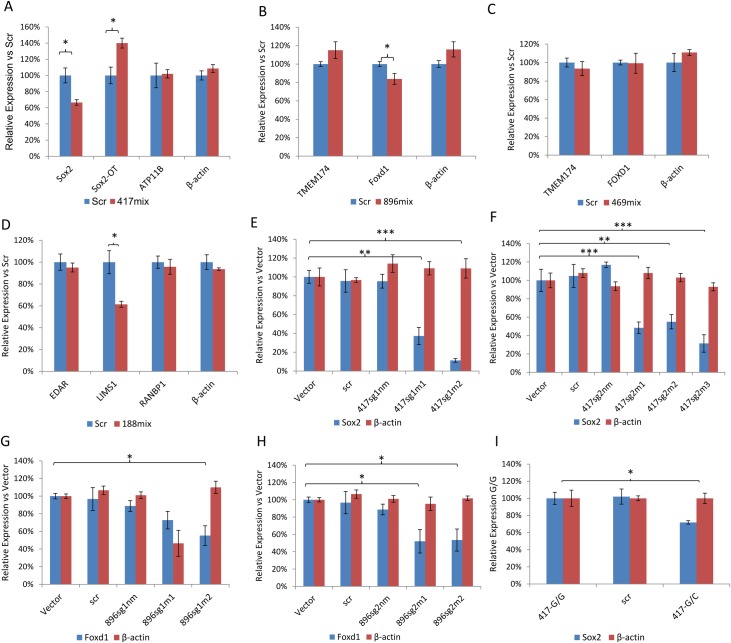
Cas9-mediated gene editing provided evidence that rs1345417 and rs12651896 affect the transcriptional activity of the nearby SOX2 and FOXD1.(A-D) qRT-PCR analysis of relative expression of nearby genes near (A) rs1345417, (B) rs12651896, (C) rs10051469 and (D) rs1866188. Scr denotes lentiCRISPR-Scramble sgRNA infected cells. 417mix, 896mix, 469mix and188mix denote CRISPR-Cas9 edited mixed clones for rs1345417, rs12651896, rs10051469 and rs1866188, respectively. (E-H) qRT-PCR analysis of relative SOX2 and FOXD1 expression in the CRISPR-Cas9 edited A375 cell clones. Especially, E) 417sg1m1-2: clone 1 and 2 edited by sgRNA1 for rs1345417; F) 417sg2m1-3: clone 1–3 edited by sgRNA2 for rs1345417. G) 896sg1m1-2: clone 1 and 2 edited by sgRNA1 for rs12651896. H) 896sg2m1-2: clone 1–2 edited by sgRNA2 for rs12651896. Detailed DNA sequencing results for each clone are shown in Supplementary Fig 4. Vector (lentiCRISPR vector infected cells), Scr (lentiCRISPR-Scramble sgRNA infected cells), sg1nm and sg2nm (cells infected with lentiCRISPR-sgRNA1 or sgRNA2 but not detectably modified near the rs1345417 and rs12651896 sites). (I) qRT-PCR analysis of relative SOX2 expression in heterozygously edited A375 cell clones, as above. 417-G/G (Original A375 cell line), Scr (lentiCRISPR-Scramble sgRNA infected cells), 417-G/C (the G/C-heterozygous A375 clone) Error bars represent standard errors. *p<0.05, **p<0.01, ***p<0.001, t-test comparing to vector control. N = 3 for each experiment.